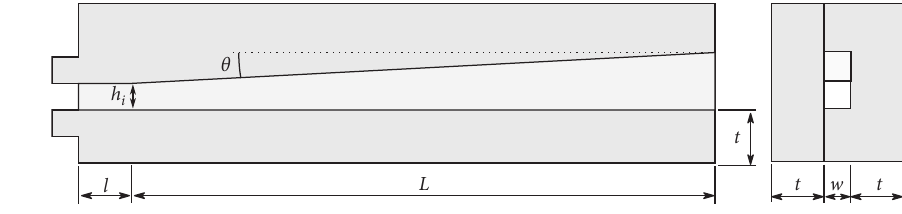
Figure 2: Fuel shape. Table 1: Detail fuel shape.